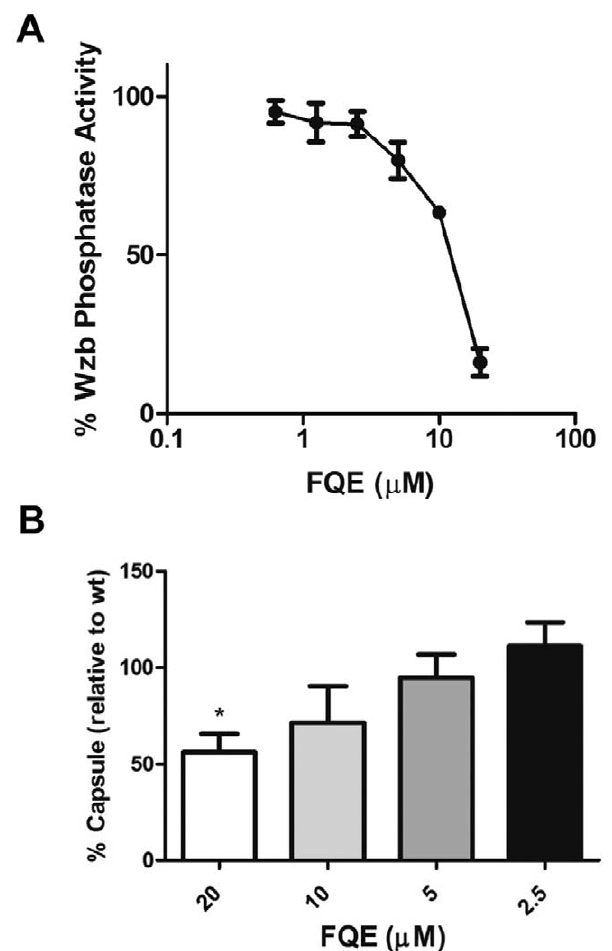
Figure 6. FQE also inhibits E.coli Wzb and CPS synthesis in K. pneumoniaeO1 . (A) His 6 Wzb dephosphorylation of p NPP in presence of FQE in 1 M Tris pH 7.0 at 37 u C. (B) Total CPS preparations from K. pneumoniae incubated with FQE were analysed by uronic acid assay. Data is from four independent experiments (20 m M vs 5 m M; * - P , 0.05 by Student’s t